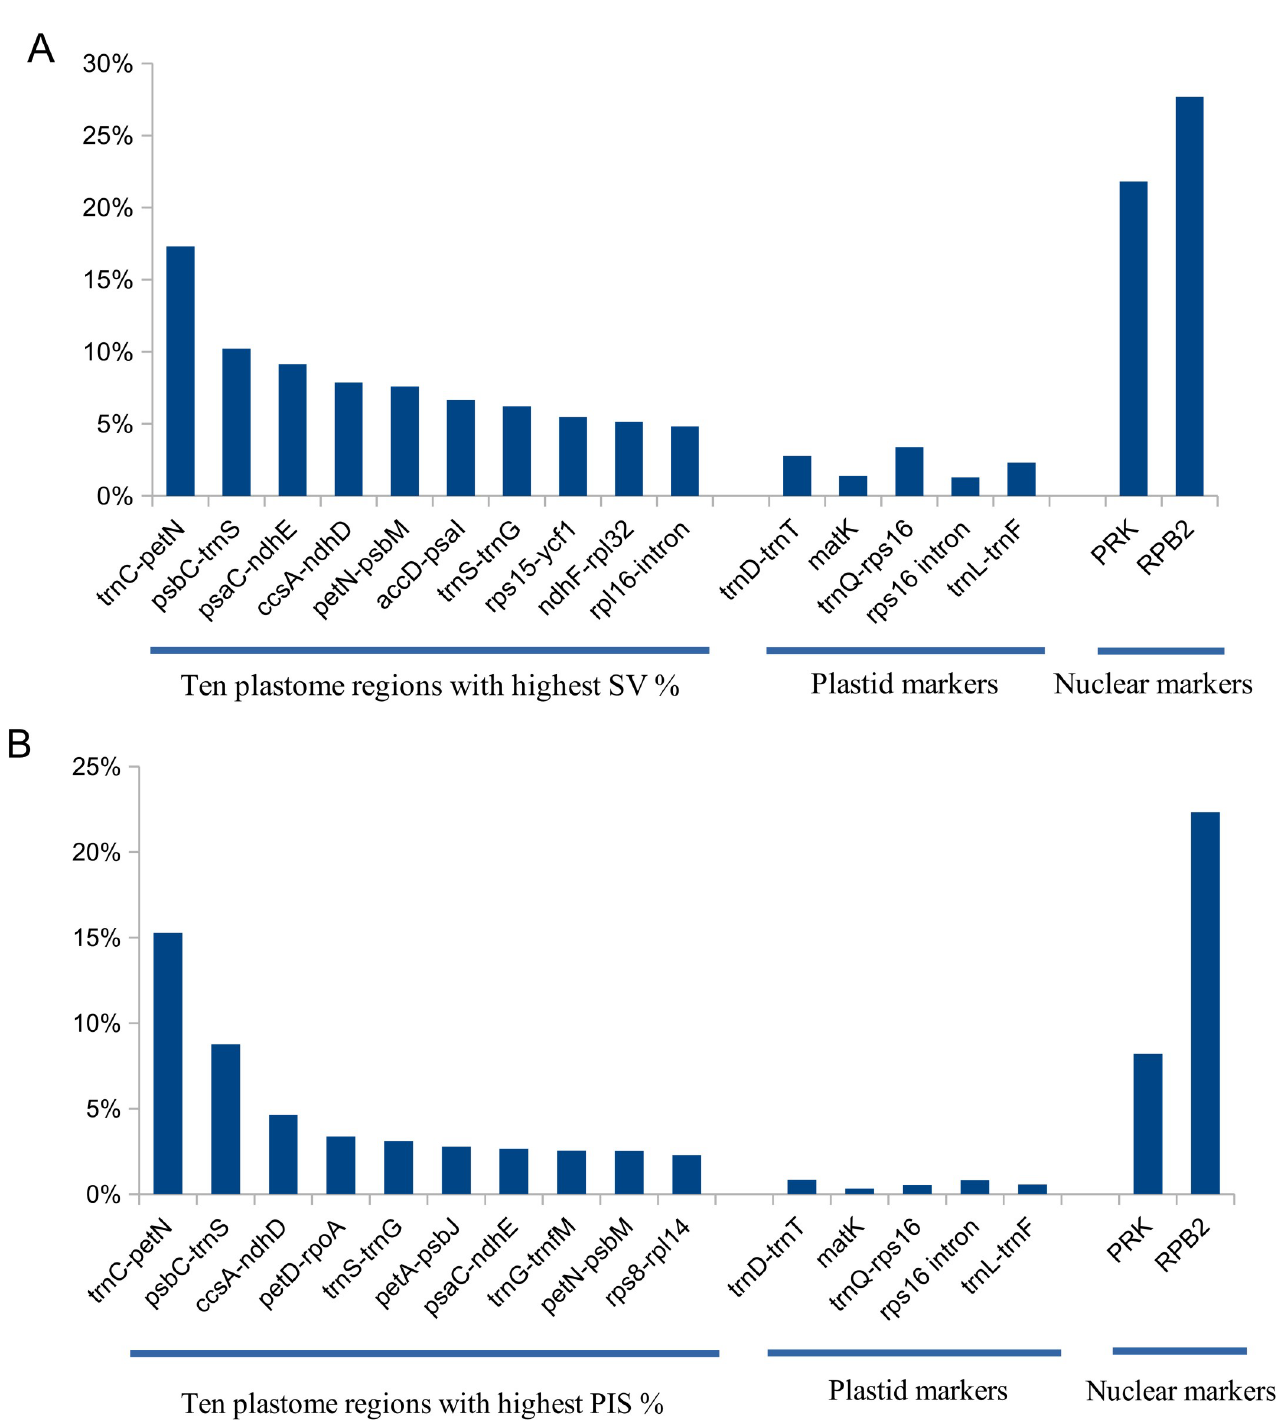
Fig 3. Hypervariable plastome regions compared with commonly used plastid and nuclear markers. A— The ten plastome regions with greatest sequence variation (SV%); B— The ten plastome regions with greatest frequency of parsimony informative sites (PIS%).